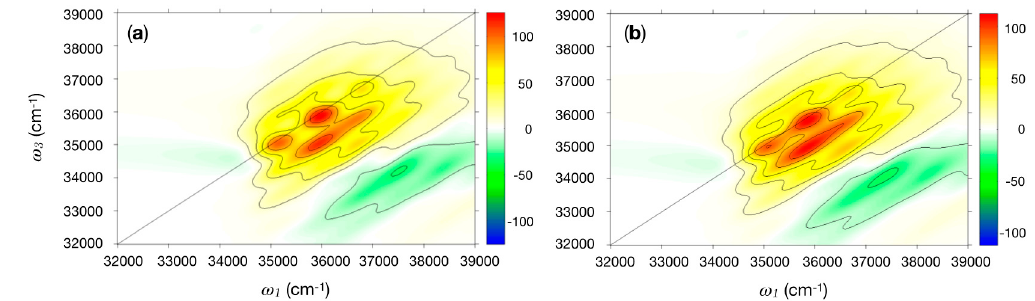
Figure 5. ( a ) 2DUV spectra in the near UV for BPTI with a pulse polarisation of xxxx for a single configuration with degenerate energies; 2DUV spectra in the near UV for BPTI with a pulse polarisation of xxxx ( b ) with electronic Hamiltonian with the electrostatic fluctuations (EHEF) correction. Plots of ω 3 (cm − 1 ) versus ω 1 (cm − 1 ) for the real part of the signal. The intensity has been renormalised to the number of Tyr (i.e., by a factor of 4 in BPTI). The spectrum in ( b ) was also averaged over the 200 MD snapshots.